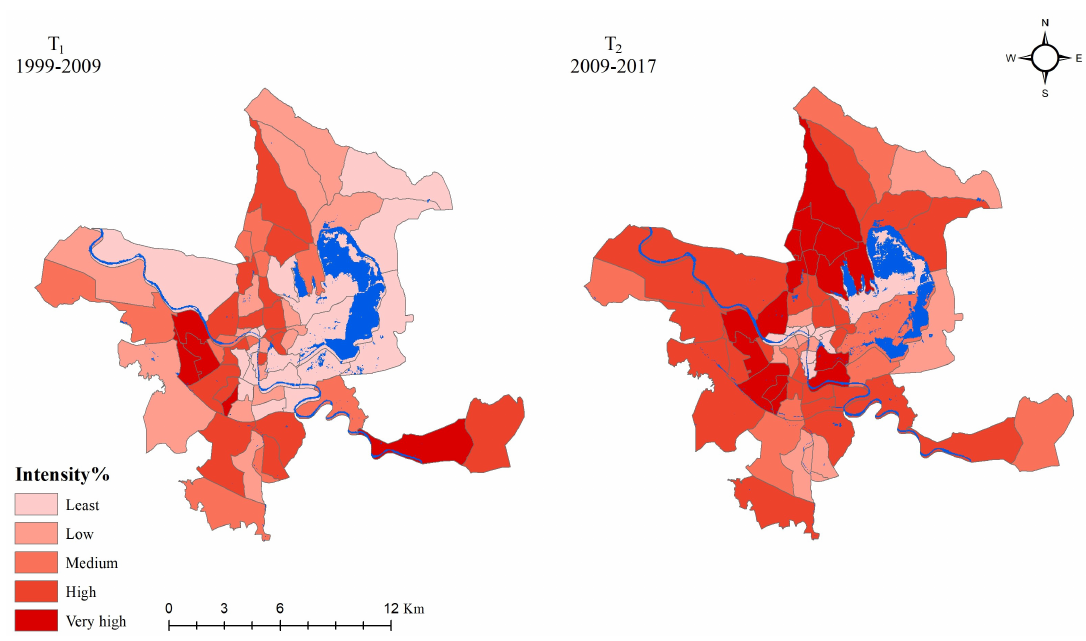
Figure 8. Changes in U ei —T 1 and T 2 categorized according to various